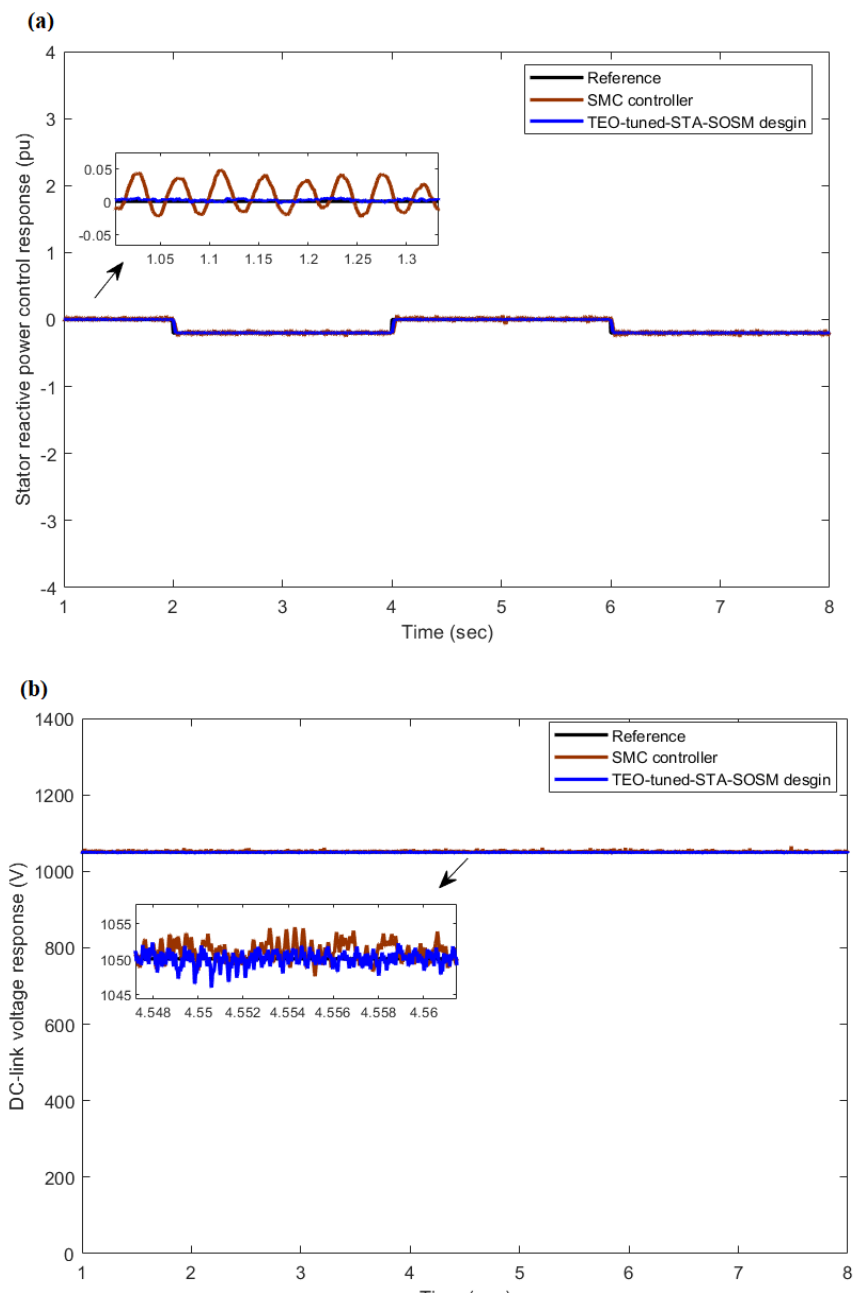
Figure 10. Chattering attenuation: ( a ) stator reactive power; ( b ) DC-link voltage.